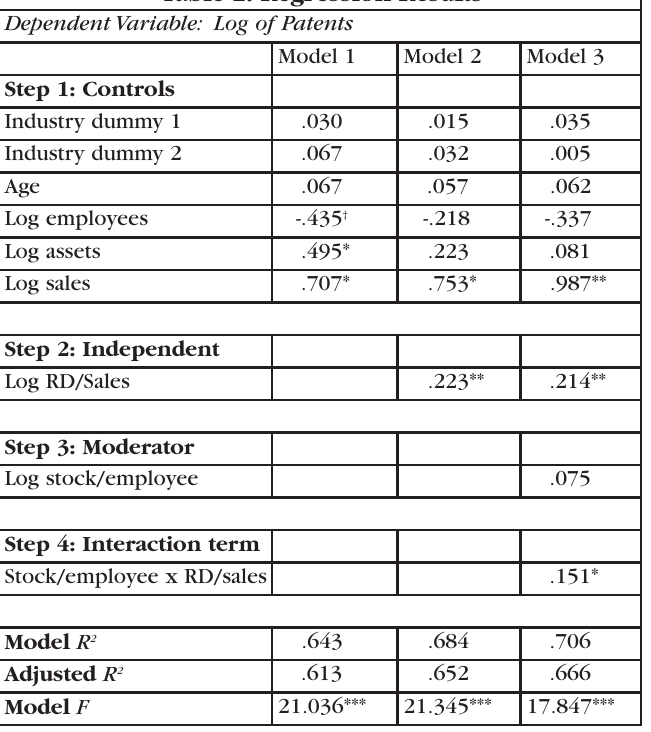
Table 2. Regression Results